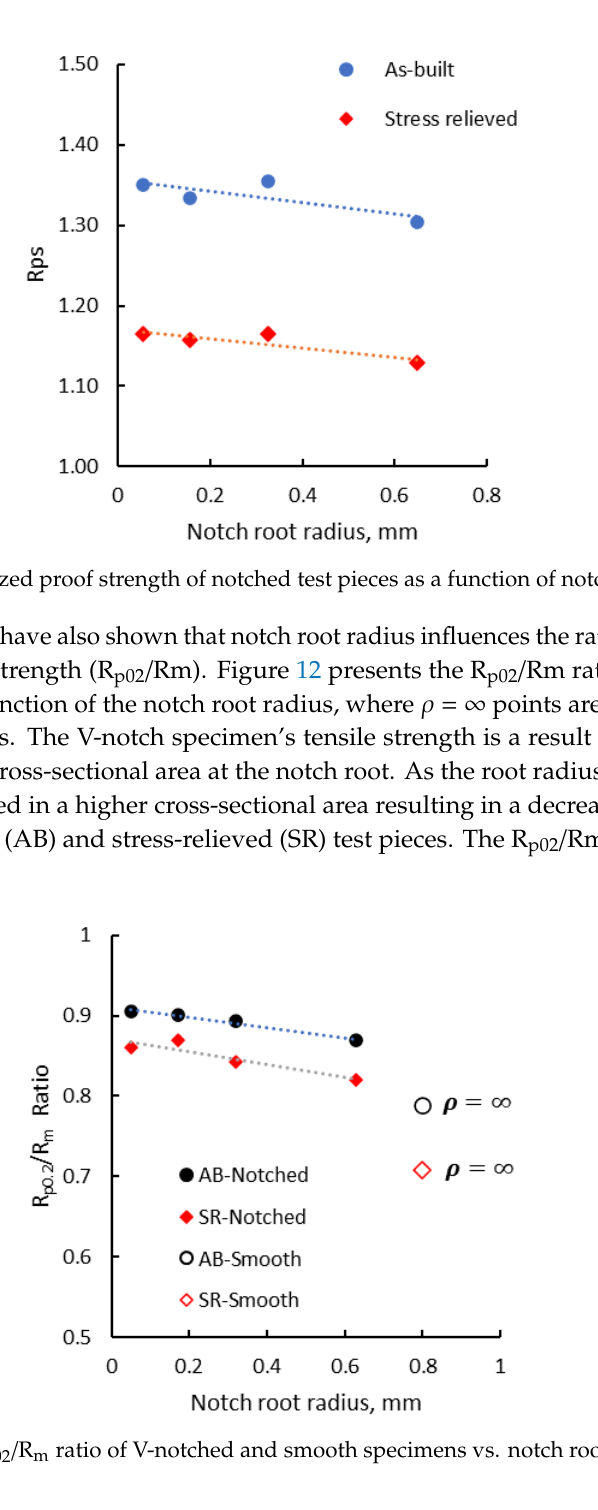
Figure 10. Stress-strain curves for V-notched test pieces with 0.05 mm notch root radius in as-built and stress-relieved states.